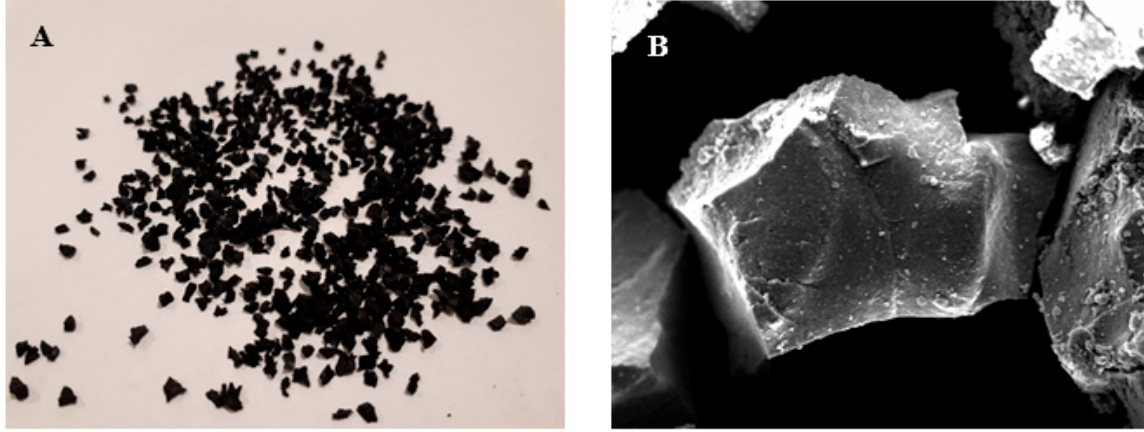
Figure 1. ( A ) Tire rubber (TR) and ( B ) tire rubber grain ( ≈ 1 mm diameter) from electron microscope detection.